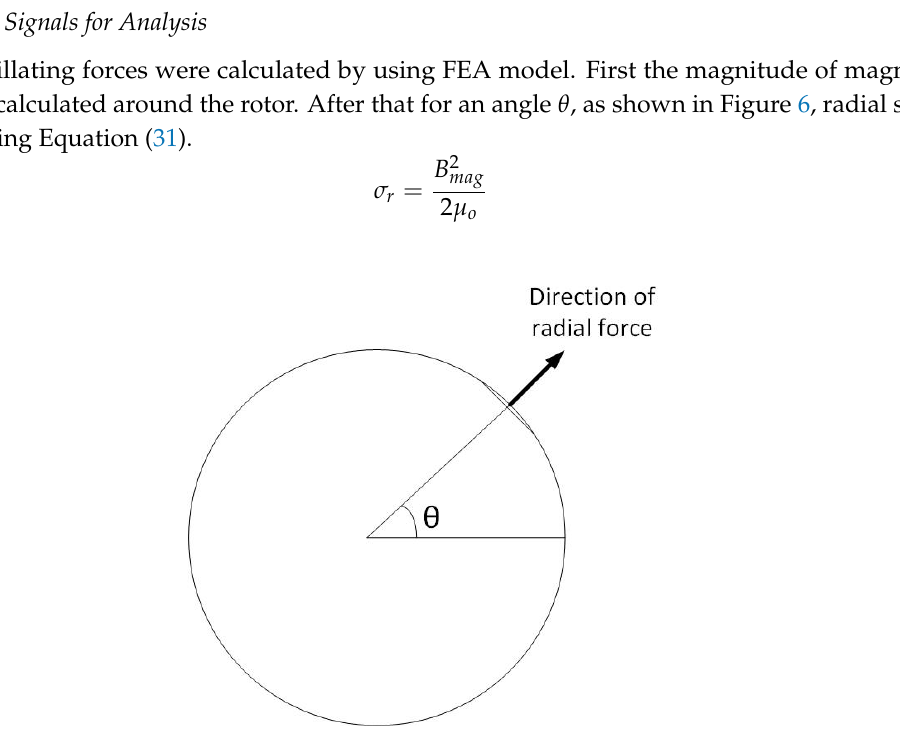
Figure 6. Calculation of forces using finite element analysis (FEA)